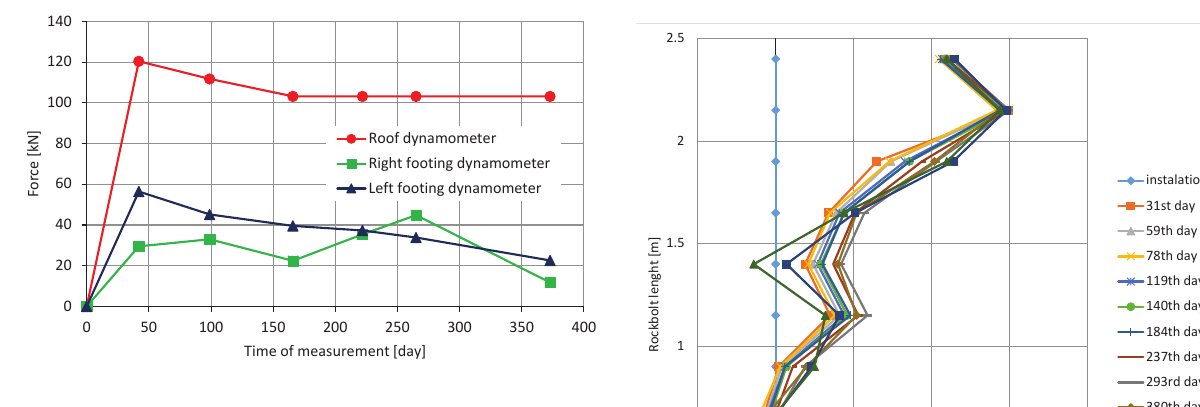
Fig. 2. Distribution of forces in dynamometers – raise gallery Z-VII Figure 2: Distribution of forces in dynamometers – raise gallery Z-VII.